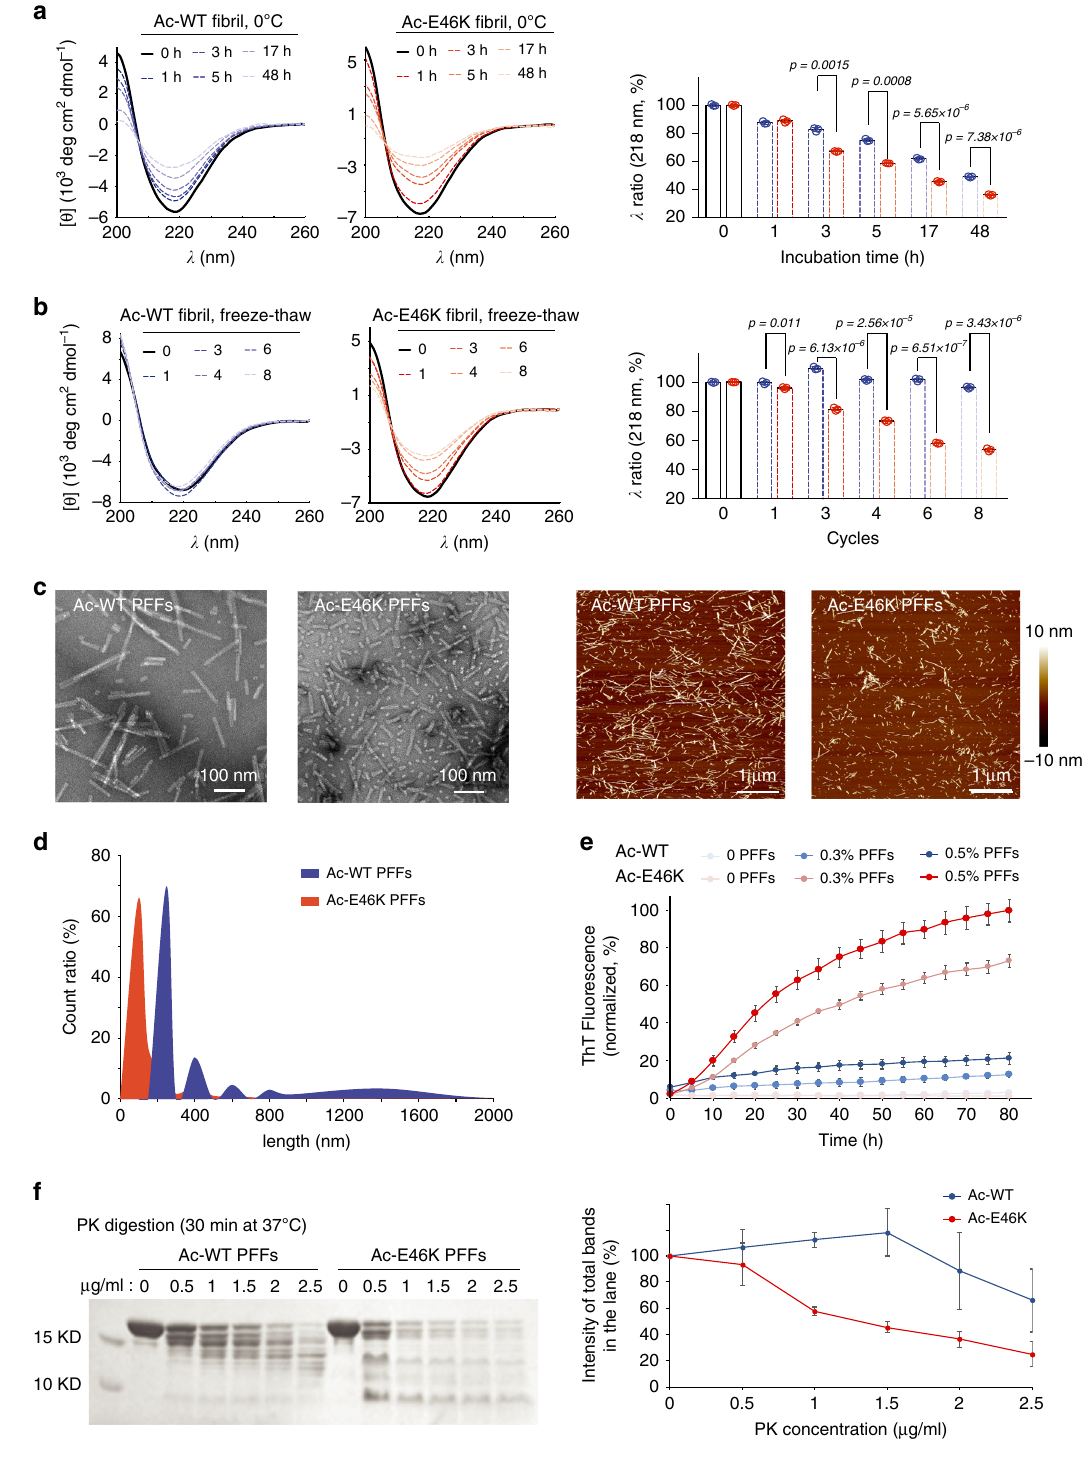
(Fig. 2), which is consistent with the AFM measurement (Sup- plementary Fig. 2). The fi bril contains two proto fi laments that intertwine along an approximate 2-fold screw axis (Fig. 2). The helical twist between α -syn subunits is − 179.37° and the helical rise is 2.38 Å (Fig. 2b, c, Table